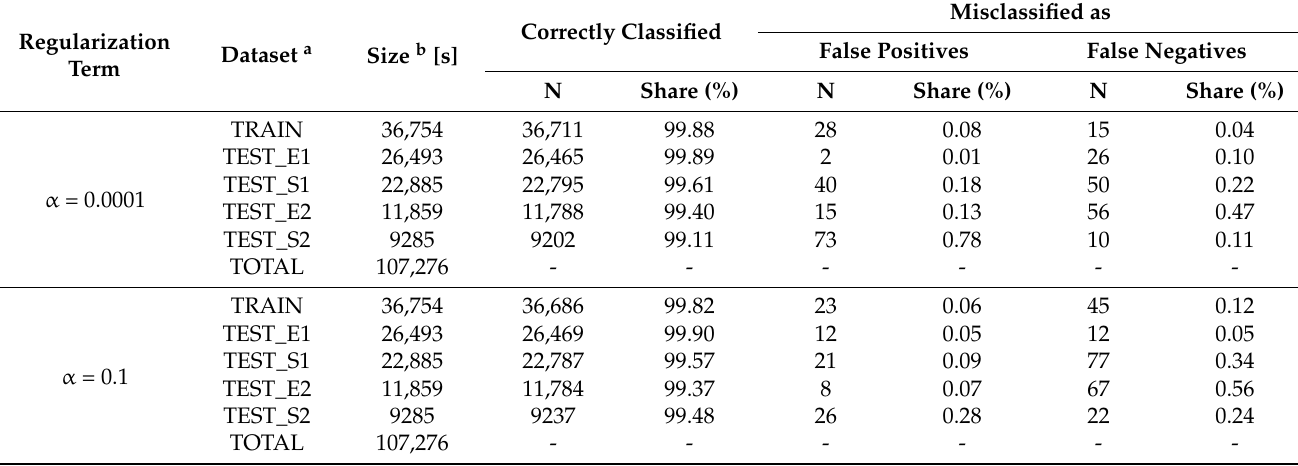
Table 4. Descriptive statistics of